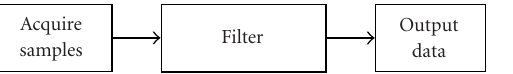
Figure 1: A rough sketch of the block diagram of a communications